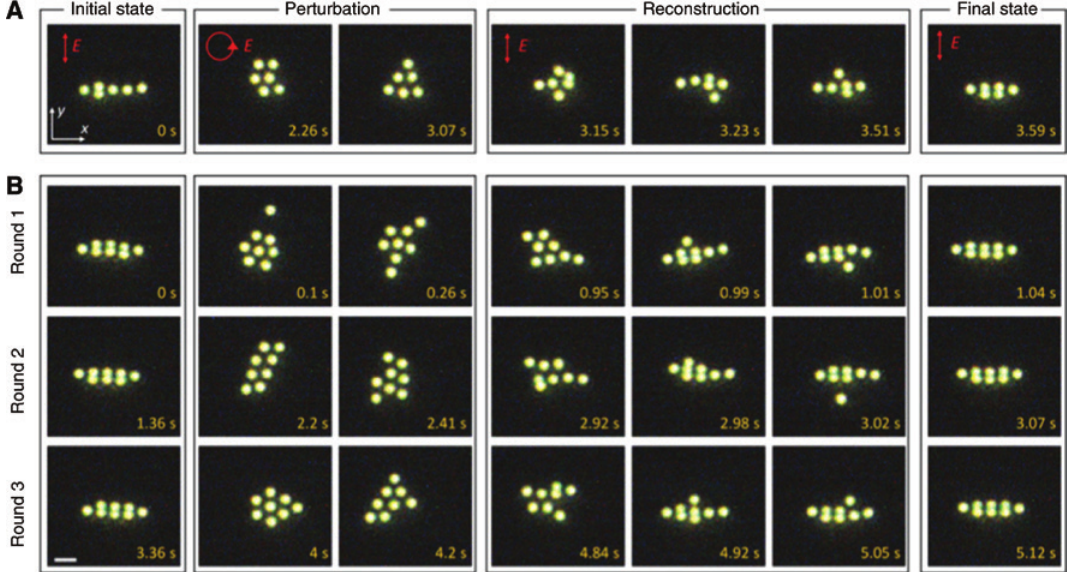
Figure 12: Dark-field optical images of light-driven self-healing of quasi-one-dimensional silver nanoparticle-based metamolecules. (A) and (B) show several silver 150 nm nanoparticles self-assembled into metamolecules using a linearly polarised optical field (first column), then transformed into unstable structures upon external perturbations (by changing from linear to circularly polarised light, second and third columns), and finally reconstructed into (A) a shorter metamolecule with two dimer units and (B) the same configurations as the initial state when the polarisation is changed back to the linearly polarised state (columns 4–7). The scale bar is 1 μ m. Reproduced with permission from